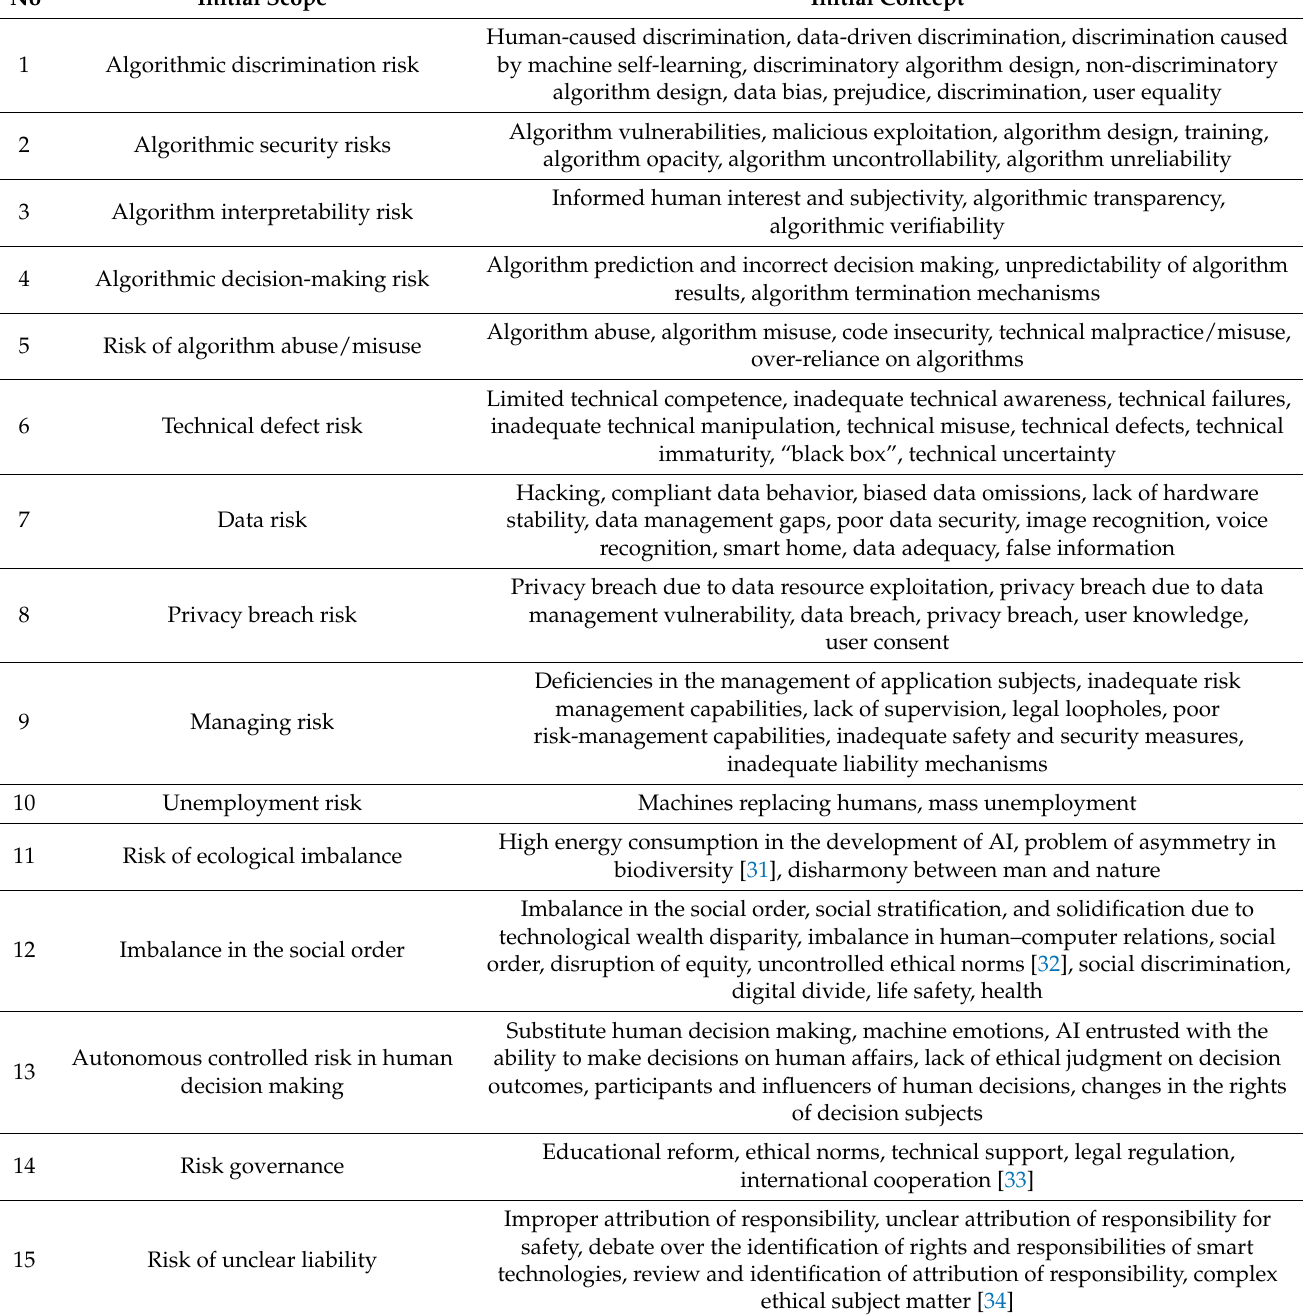
Table 1. Examples of open coding and